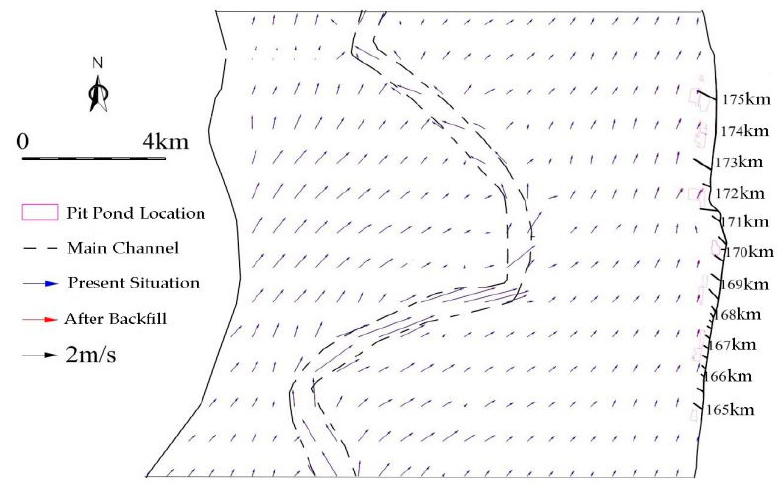
Figure 6. Variation of flow field under the floodplain condition (Q = 22,000 m 3 /s ) .